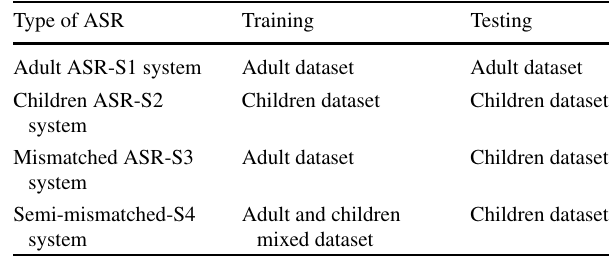
Table 1 Detailed information of Punjabi adult and children corpora Characteristics